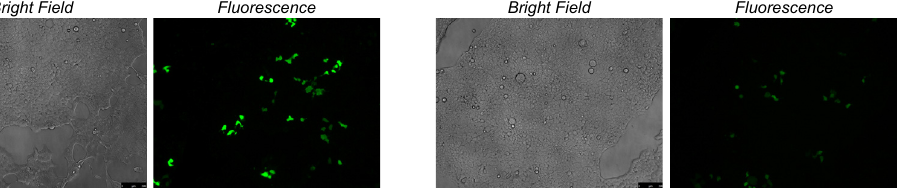
Figure 3. Titers of Spike-pseudotyped lentiviral particles in 293T-ACE2 cells. ( A ) Titers of the ZsGreen backbone pseudotyped with the three Spike variants or VSV G, as determined by counting green cells via flow cytometry analysis at 48 h post-infection and then calculating transduction-competent viral particles per mL from the percentage of green cells. The “n.d.” indicates that the titer was not detectable. Data shown are from a single representative example. ( B ) Titers of the Luciferase-IRES-ZsGreen backbone as determined by measuring relative luciferase units (RLUs). RLUs were determined at 48 h after infecting ~2.3 × 10 4 293T-ACE2 cells per well in 96-well plates. The RLUs per mL for the Spike-pseudotyped viruses are the average of three three-fold serial dilutions of virus starting at 50 µ L virus in a total volume of 150 µ L. For the VSV G-pseudotyped virus, RLUs per mL were averaged from two three-fold dilutions starting at 3 µ L virus in a total volume of 150 µ L. ( C ) Microscope images showing 293T-ACE2 cells transduced with Spike pseudotyped virus with either the ZsGreen or Luciferase-IRES-ZsGreen backbone at 60 h post-infection. As can be seen from the images, the ZsGreen backbone gave a stronger fluorescent signal than the Luciferase-IRES-ZsGreen backbone, presumably because this protein was expressed more strongly as the sole CMV-promoter driven transcript than as the second transcript driven by an IRES.